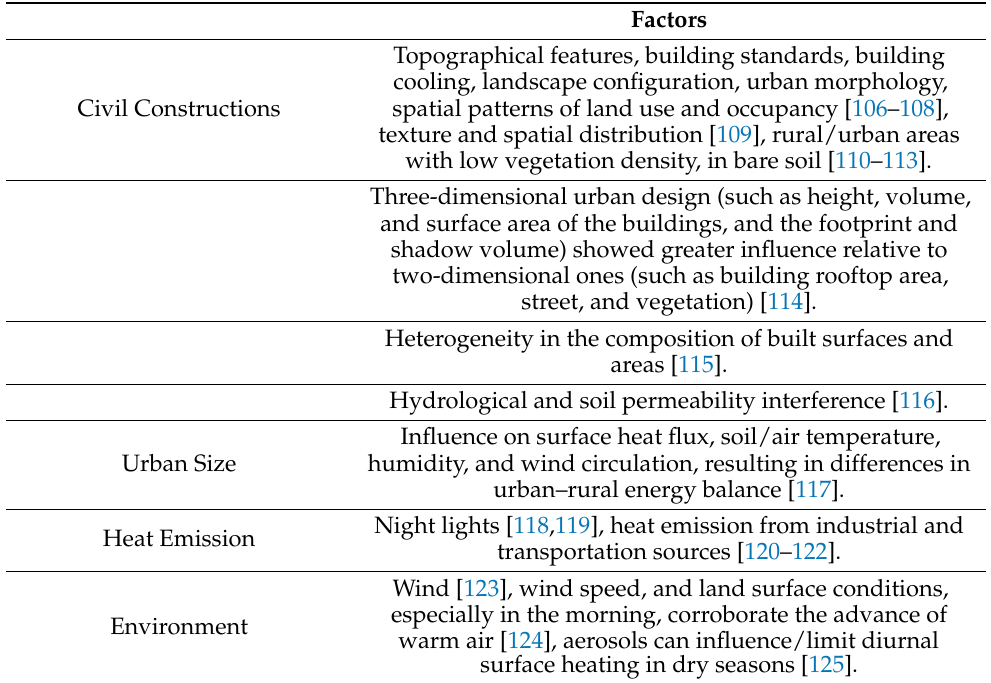
Table 13. Highlight of some reasons for UHI and SUSHI ´ s formation.